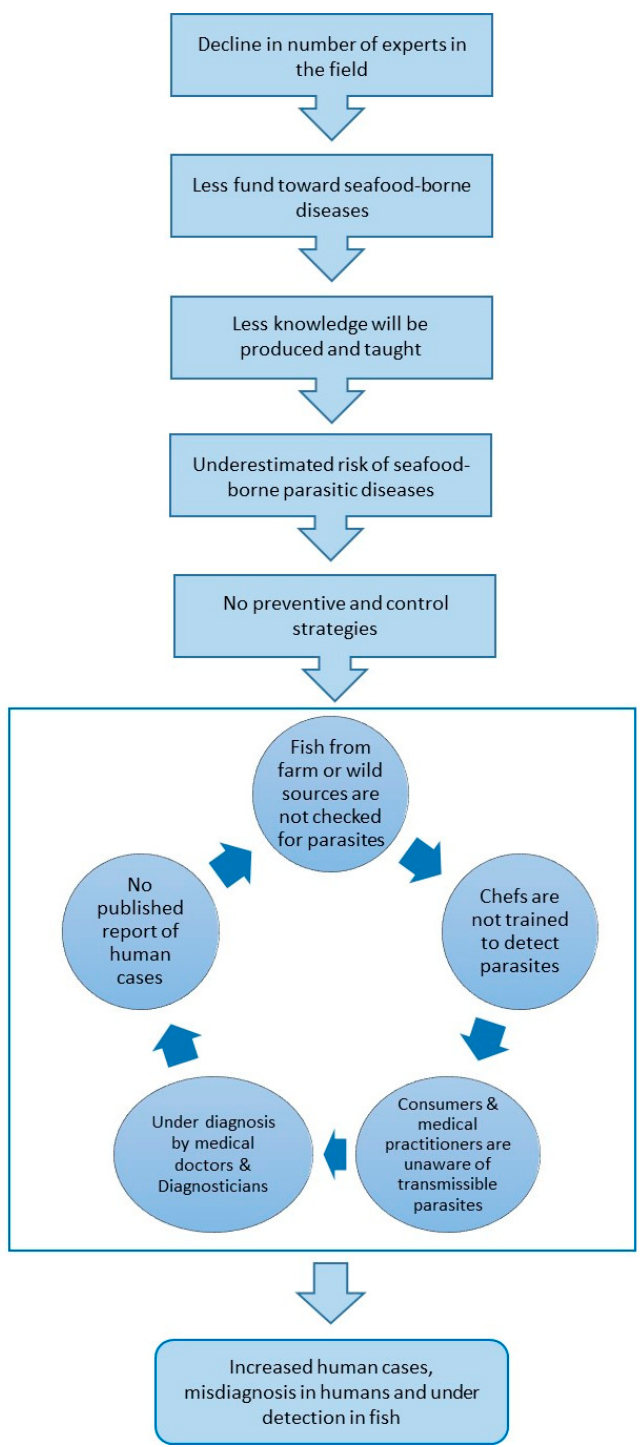
Figure 1 . Diagrammatic view of the significance of the communications between various stakeholders in terms of being aware of seafood safety